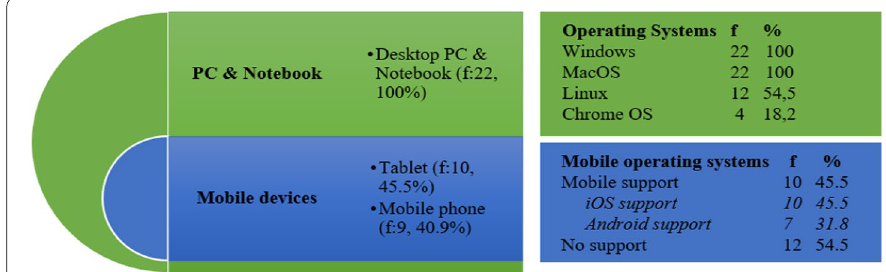
Fig. 2 Device, operating system, and mobile operating system